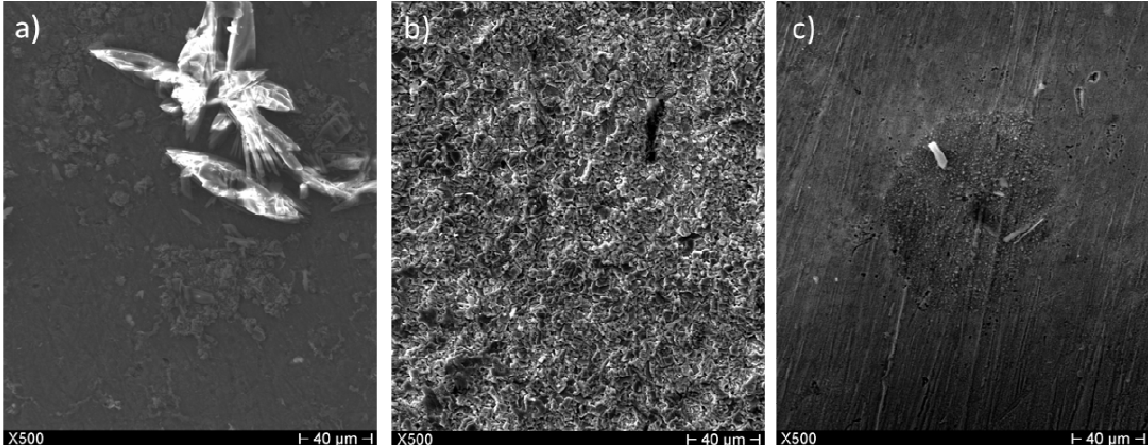
Figure 4. SEM secondary electron images at ×500 for the 3% Sn sample immersed for five weeks in ( a ) synthetic acid rain solution; ( b ) 0.1 M sulphuric acid; and ( c ) 0.1 M nitric acid.